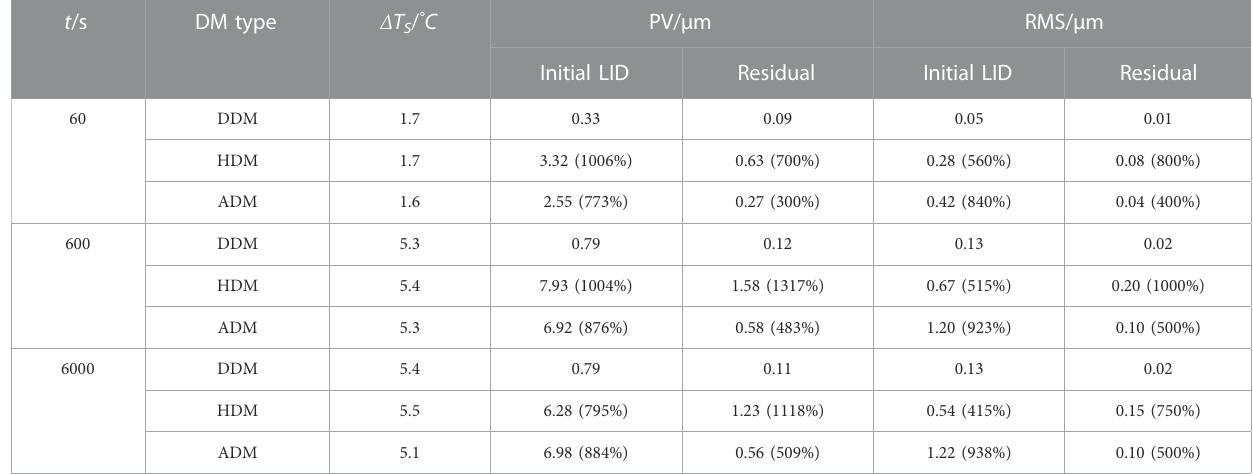
TABLE 3 LID and mirror temperature results of the DDM, the HDM, and the